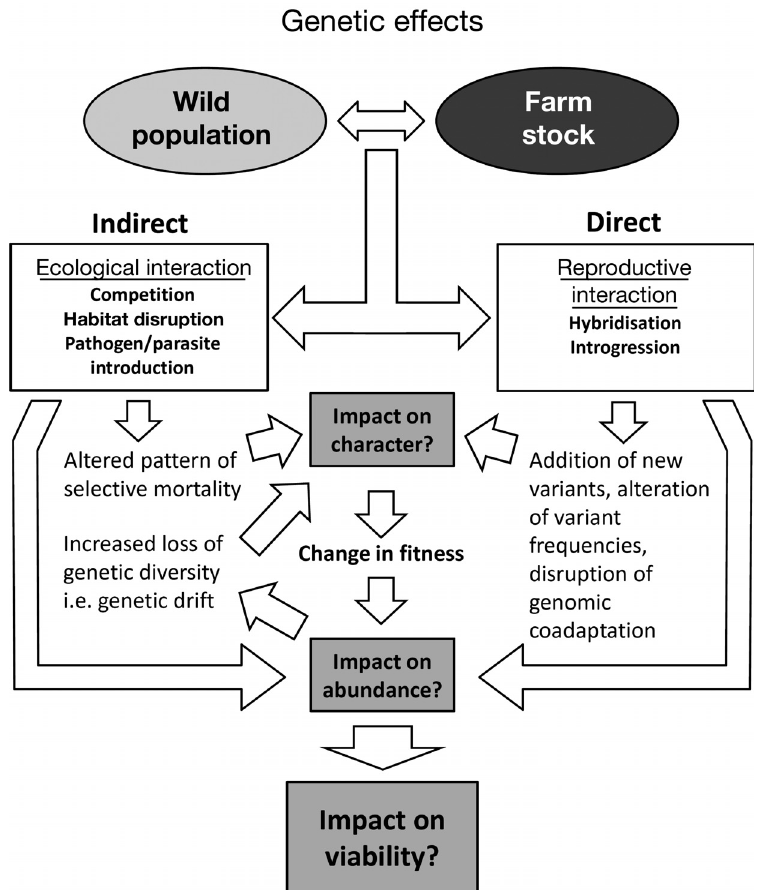
Fig. 1. Schematic of reproductive and non-reproductive genetic interactions be tween wild and domestic Atlantic salmon Salmo